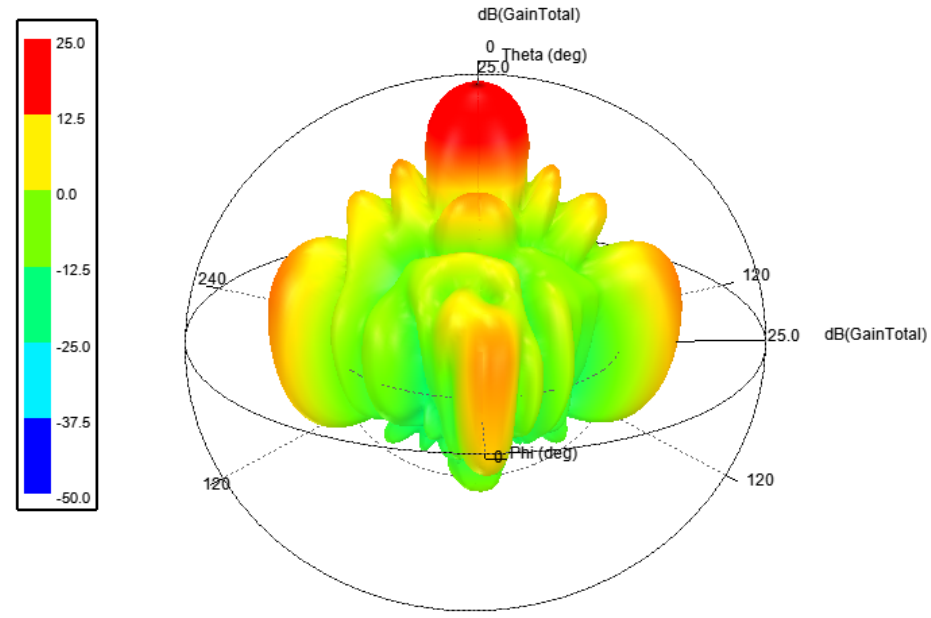
Figure 15. The 3D EM simulation